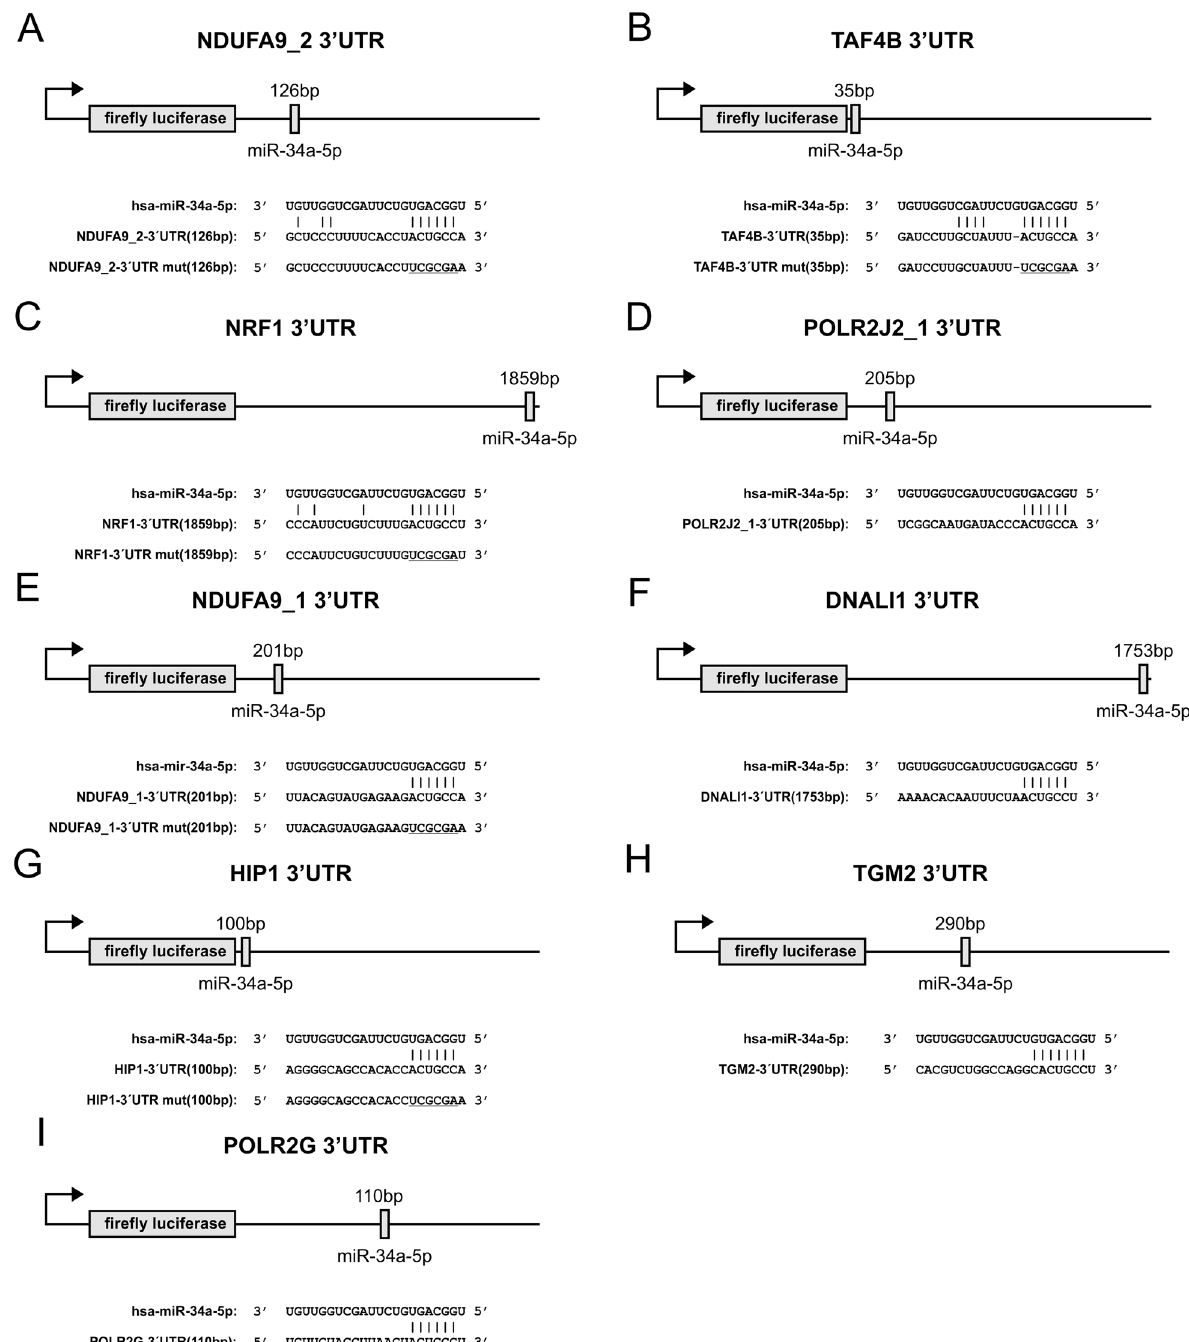
Fig. 3 Schematic representation of reporter gene constructs. The location of the predicted miR-34a-5p binding sites in the respective 3’UTR reporter vectors, their corresponding sequences and the sequences of the respective mutated binding sites (underlined) are given. A NDUFA9_2-3’UTR reporter construct, B TAF4B-3’UTR reporter construct, C NRF1-3’UTR reporter construct, D POLR2J2_1-3’UTR reporter construct, E NDUFA9_1-3’UTR reporter construct, F DNALI1-3’UTR reporter construct, G HIP1-3’UTR reporter construct, H TGM2-3’UTR reporter construct, I POLR2G-3’UTR reporter